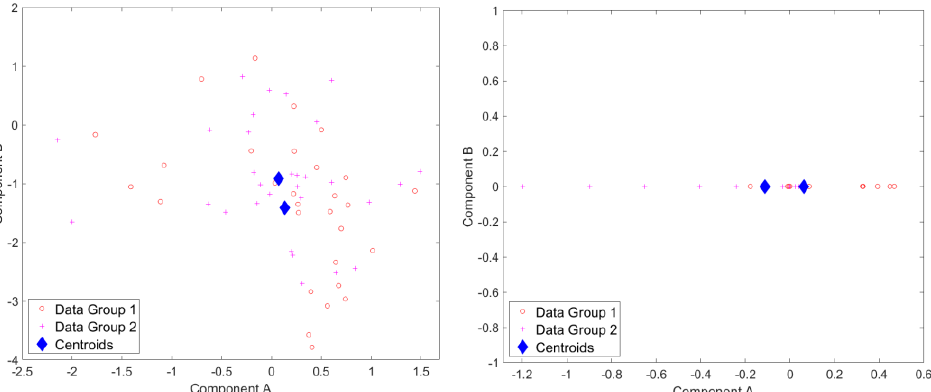
Figure 9. Results of standardized component scores for the Smile dataset: ( left ) single-level PCA; ( right ) level 1, mPCA. These results show only minor differences in dynamic 3D trajectories between males and females as the centroids for the two groups are quite close together.